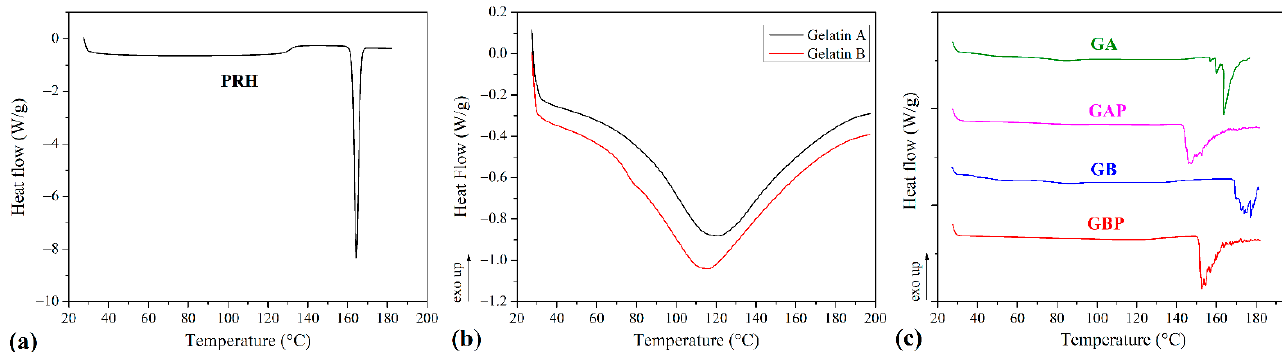
Figure 5. Differential scanning calorimetry (DSC) diagrams of ( a ) propranolol hydrochloride (PRH); ( b ) gelatin A and gelatin B powder, ( c ) pure gelatin A film (GA), gelatin A film loaded with PRH (GAP), pure gelatin B film (GB) and gelatin B film loaded with PRH (GBP). Table 2. Temperatures from DSC